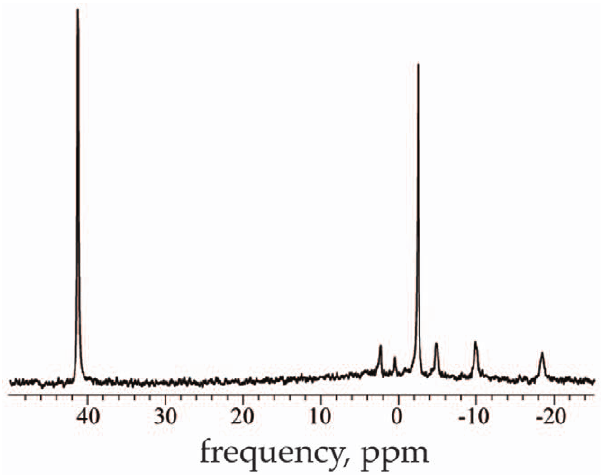
Figure 2. A sample in vivo spectrum with real peaks and the artificially injected pseudo-peak. The Pi, PCr and the c , a , and b moieties of ATP appear at about 2.5, 0.5, 2 2.5, 2 5.0, 2 10, and 2 18.5 ppm, respectively. The pseudo-peak appears at 41 ppm. The amplitude, frequency, phase, and line-width of the pseudo-peak are determined by the digitized waveform transmitted by the RF synthesizer and are easily adjusted.